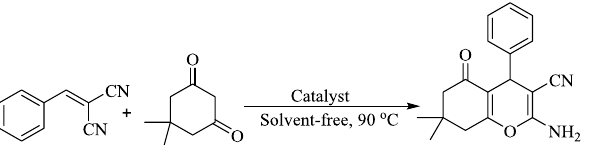
Figure 18. Reaction between 2-benzylidenemalononitrile and dimedone for synthesis of 2-amino-3-cyano-4 H - chromene.